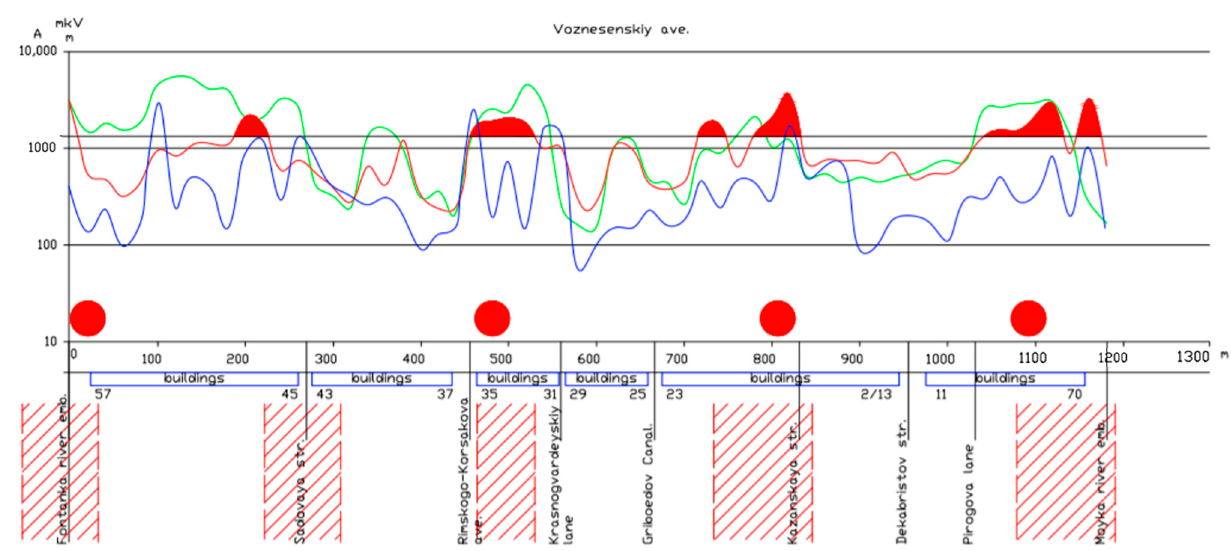
Figure 1. The results of the measurement of the magnetic component (MC) of the Earth’s natural pulse electromagnetic field (ENPEMF) along Voznesenskiy Avenue, Saint Petersburg, Russian Federation.